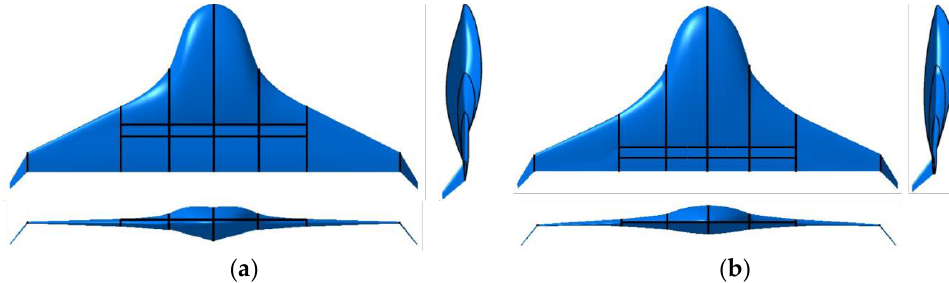
Figure 12 . Comparison of the BWB configuration between before and after the design process. ( a ) Baseline configuration. ( b ) Designed configuration.